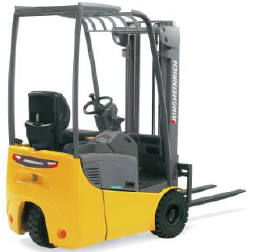
Figure 3. EFG 110 from Jungheinrich.